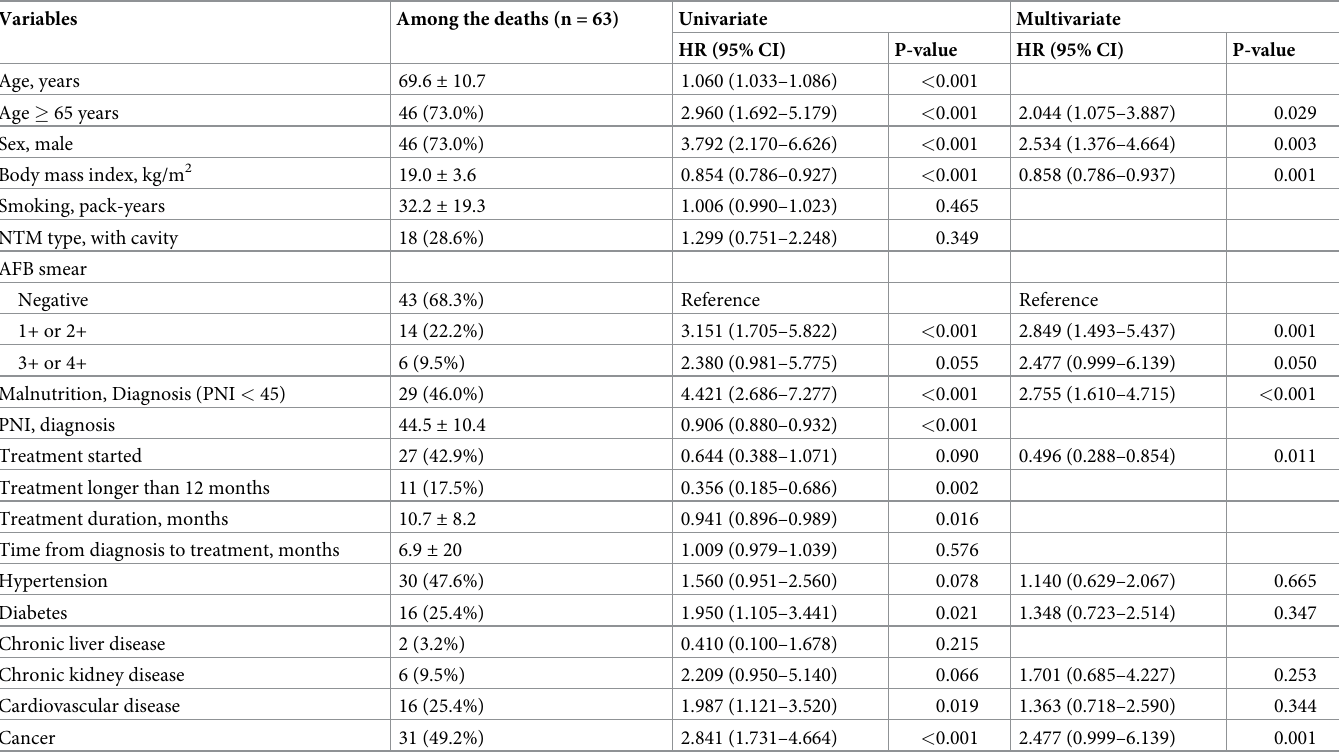
Table 5. Univariate and multivariate Cox’s proportional hazard analyses of factors for mortality in Mycobacterium avium complex lung disease